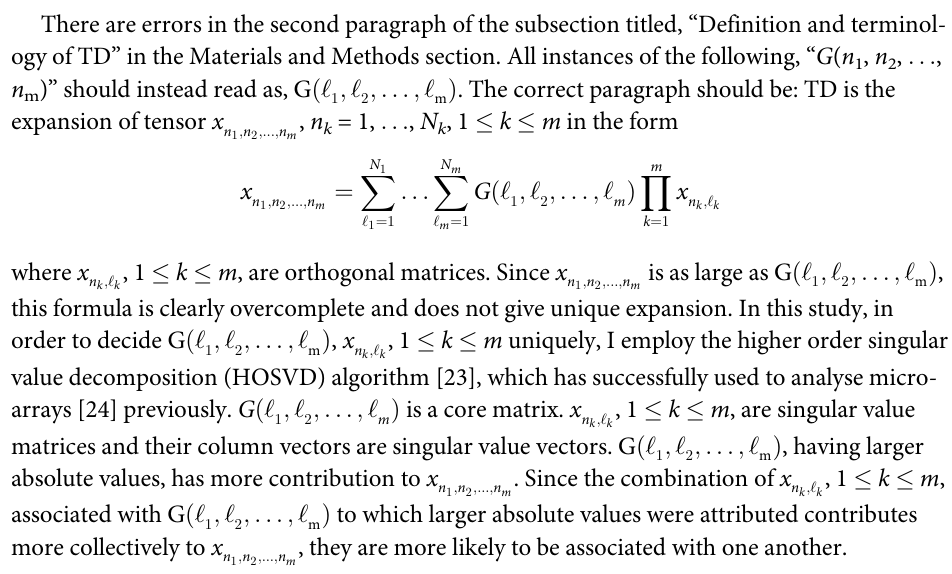
Fig 1. Boxplots of sample singular value vectors x ℓ3,j (a) when TD was applied to the type I tensor and ~ x mRNA the type II tensor, generated from mRNA and miRNA expression profiles of multi-omics datasets. (d) Sample singular value vectors when HO GSVD was applied to multi-omics datasets. P -values computed by categorical regression attributed to (a) to (d) were below the